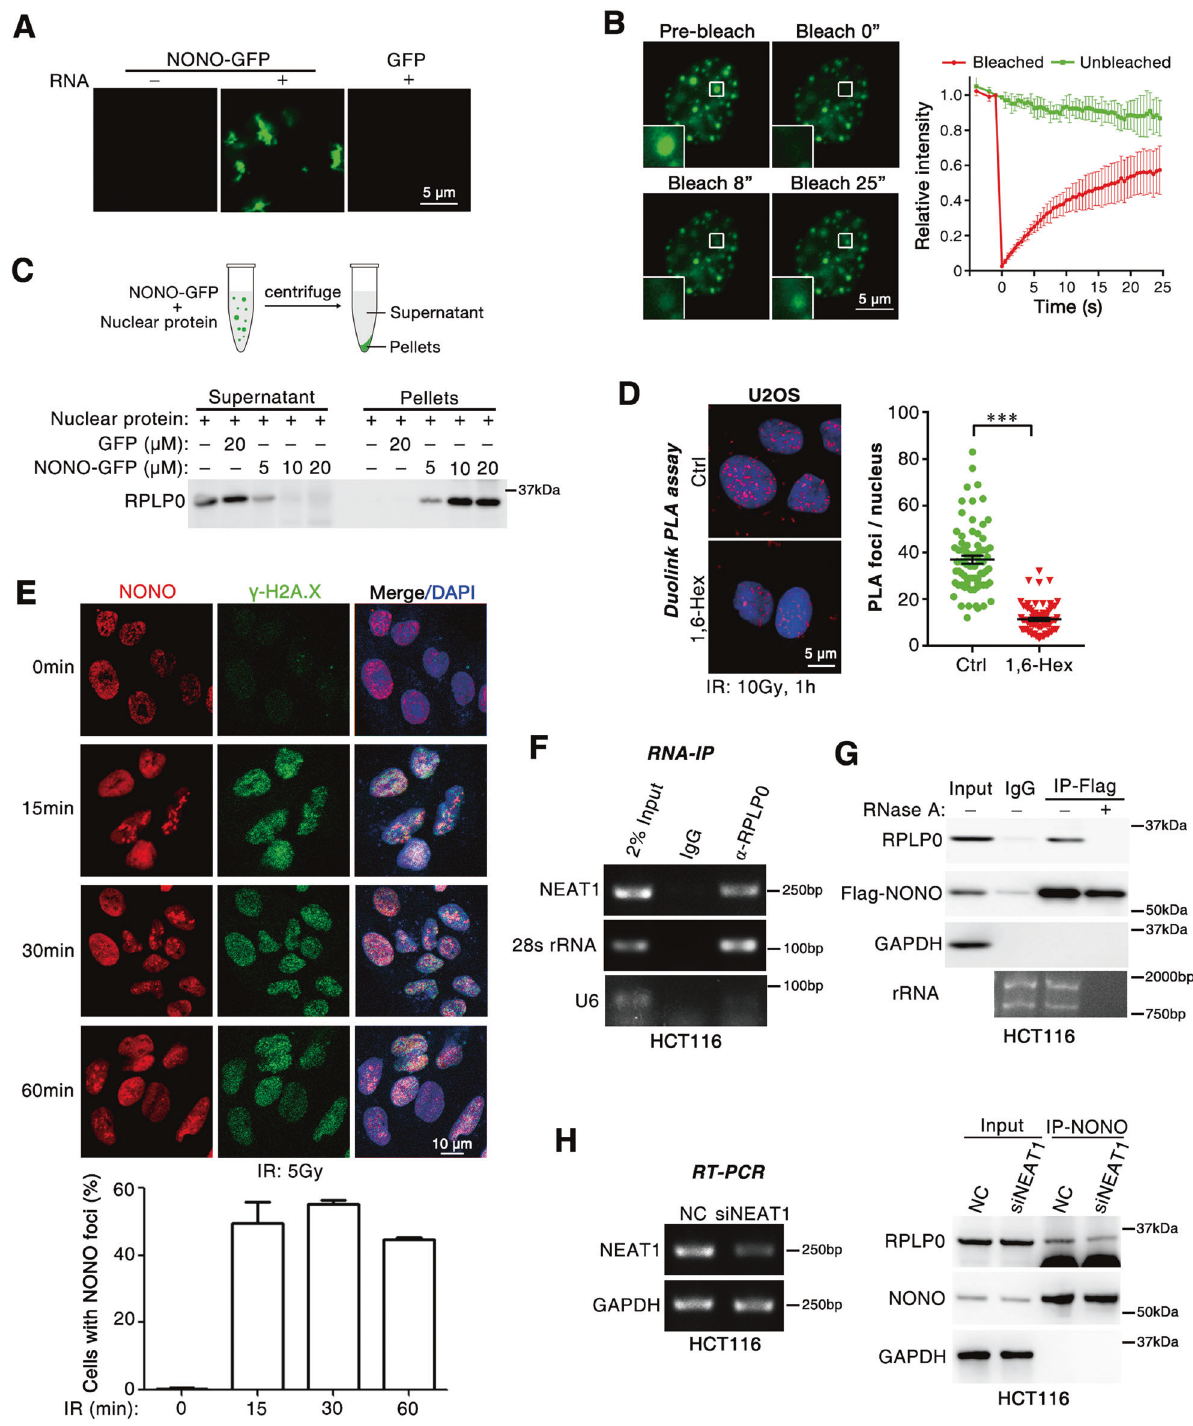
radioresistance of cancer cells (Fig. 6I). Additionally, the TCGA database showed that RPLP0 and NONO were highly expressed in a variety of cancer types (Fig. S6A), and survival analysis con fi rmed that high expression of RPLP0 and NONO was associated with an inferior prognosis of cancer patients (Fig. S6B, C). Together, these data suggest that IR-induced NONO/RPLP0 complex promotes DSB repair and tumor radioresistance by binding to damaged DNA and enhancing the phosphorylation of DNA-PK at